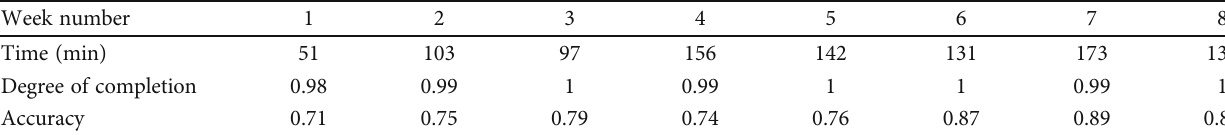
Figure 5: Academic mood changes in 45 minutes. Table 2: Statistical table of academic mood and learning